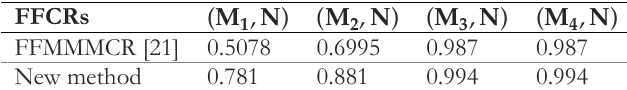
Table 5. Comparison for the FFCRs for problem 1